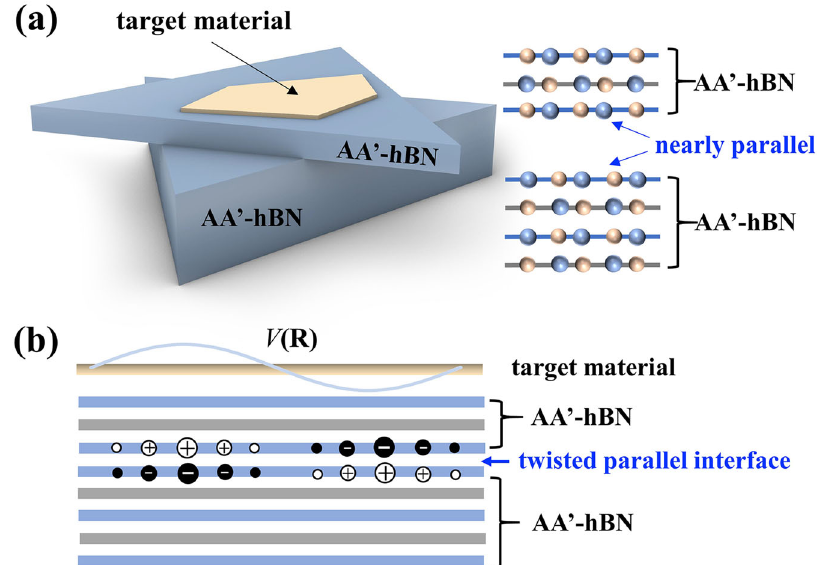
Fig. 1 Creating superlattice potential in a general 2D material from the twisted h-BN substrate. a A moiré interface of nearly parallel alignment is created inside the h-BN substrate by stacking a n -layer AA ′ -h-BN on another AA ′ -h-BN fi lm. b Spontaneous charge redistribution at this interface leads to electrical polarization patterned with periodicity controlled by twisting angle δ , which produces an electrostatic superlattice potential V ( R ) in the target material with strength controlled by n and δ